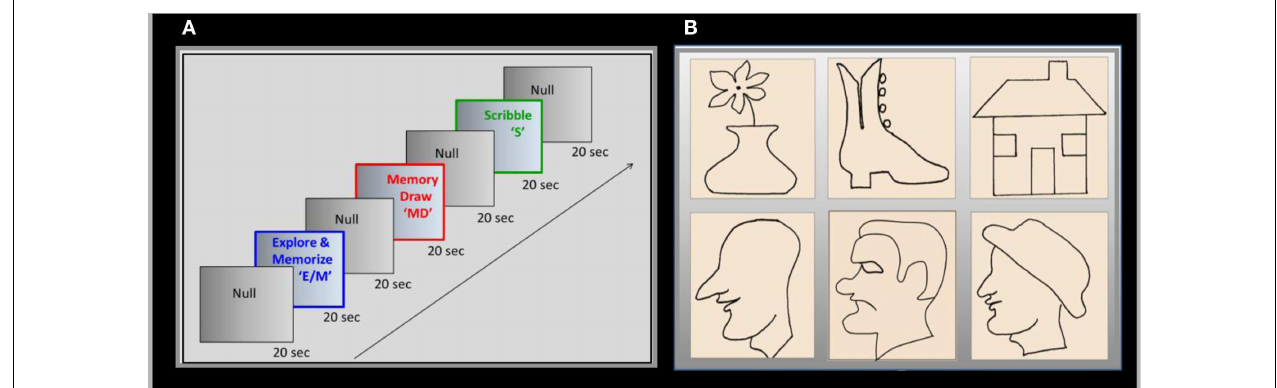
between the tasks, the whole 140s trial sequence being repeated 12 times in each scanning session using a new image for each repeat. (B) Raised-line drawings of realistic faces and objects were presented as templates to be explored by the subject using her left hand.The quality of the reproductions was assessed by a masked rating procedure, based on recognition and similarity to the templates (examples of reproduction are shown in Figure 3